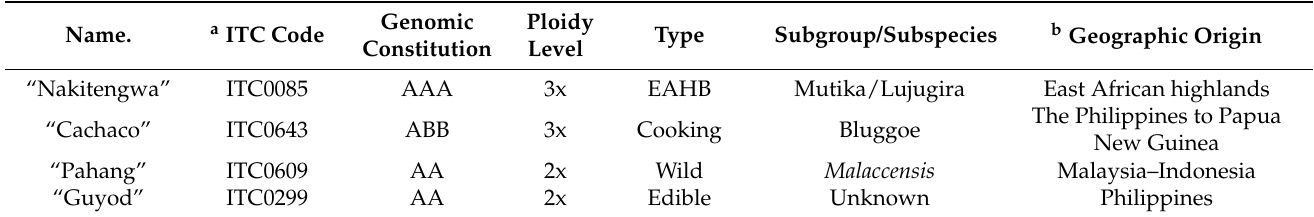
Table 1. Description and characteristics of the four Musa genotypes evaluated in this study.